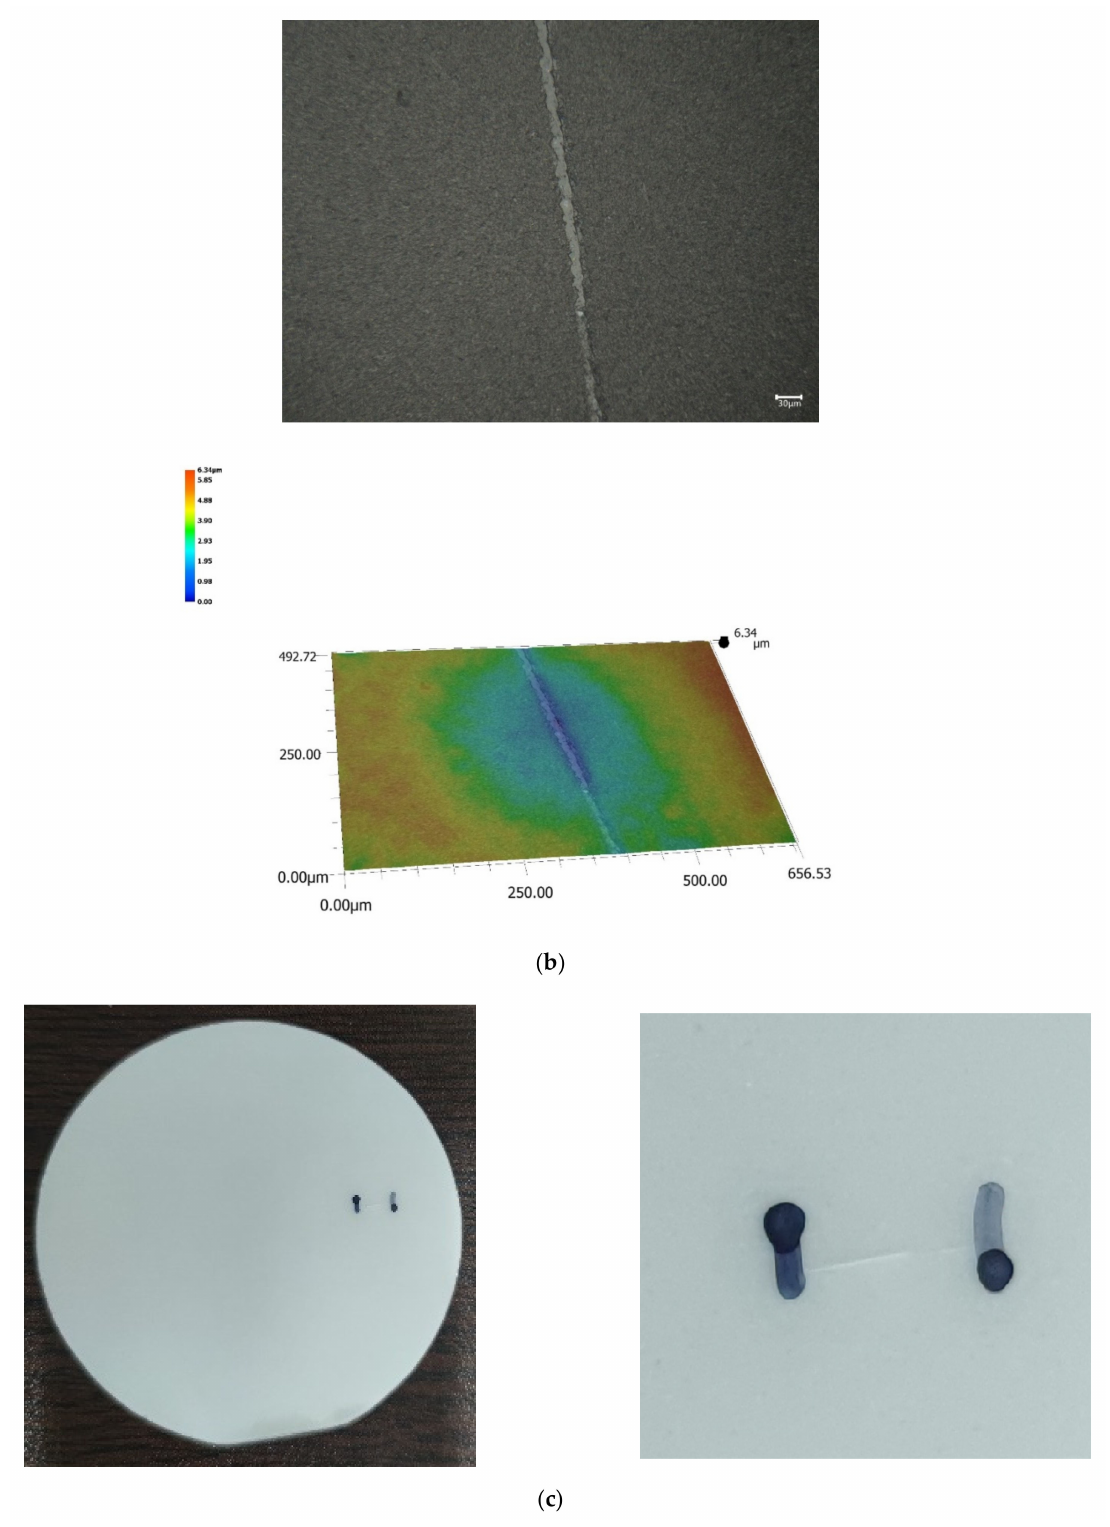
Figure 15. Observation of high-load lapping surface. ( a ) Two-dimensional and three-dimensional observation of a 25 N load; ( b ) Two-dimensional and three-dimensional observation of a 35 N load; ( c ) 40 N Load Surface